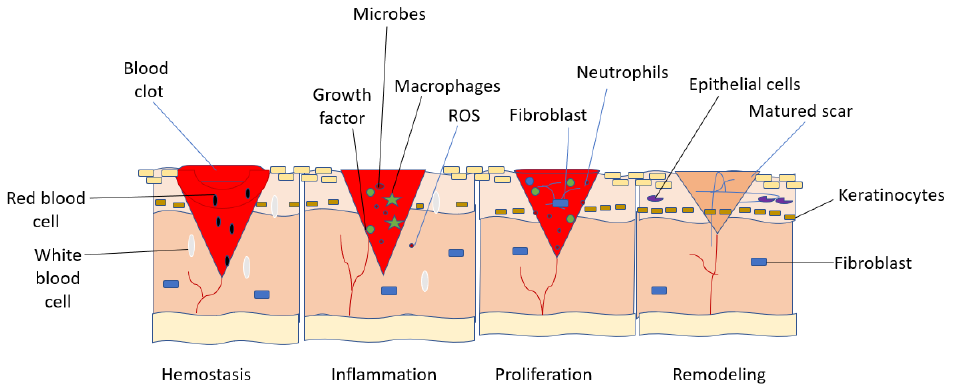
Figure 1. The phases of wound healing .